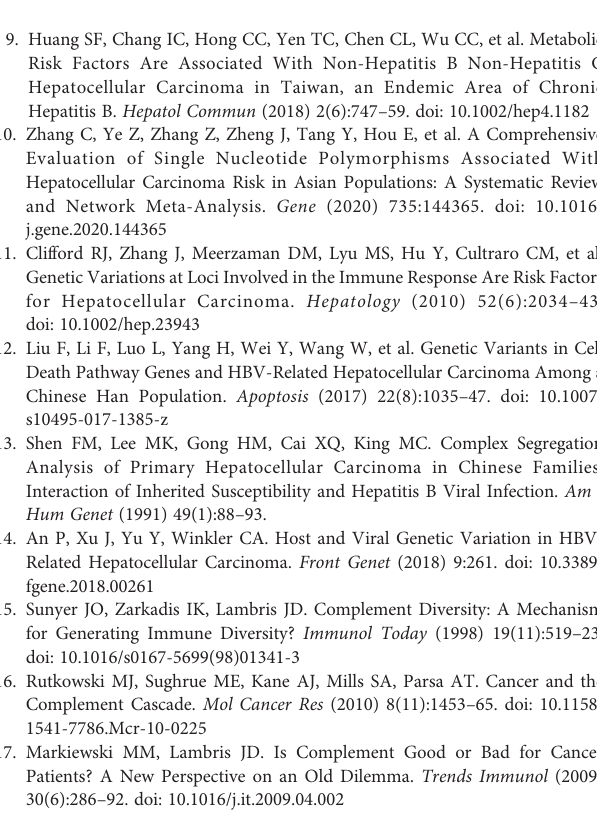
Supplementary Figure 1 | MALDI-TOFgenotyping and direct sequencing map for CD35 rs7525160. (A) The three genotypes of CD35 rs7525160